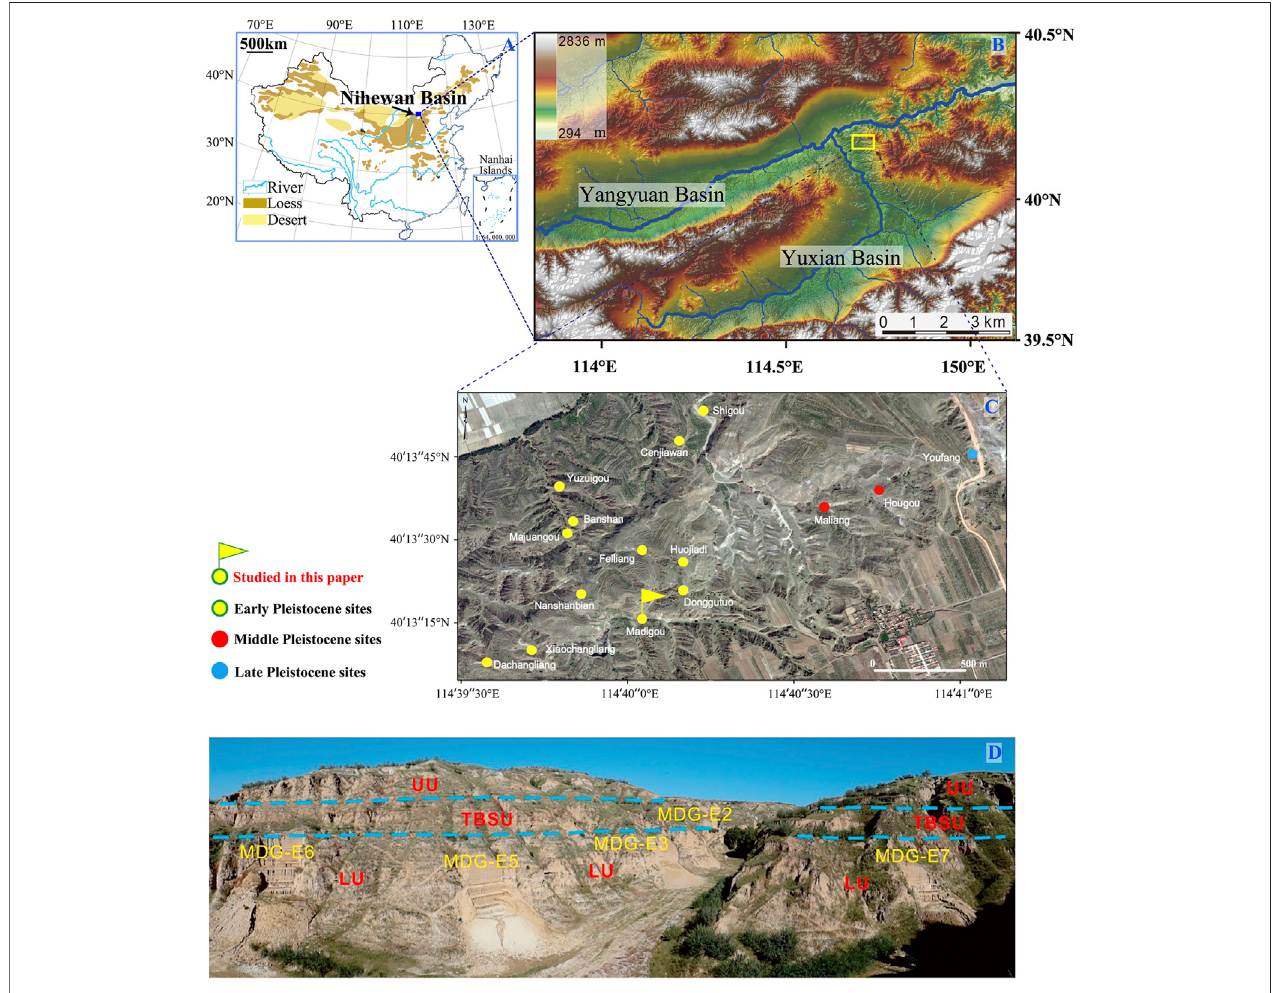
FIGURE 1 | (A – C) Location of the Nihewan Basin in China and the distribution of key Pleistocene sites in the Cenjiawan Platform. (D) Trenches at the MDG site complex, viewed from the southwest. Abbreviations: LU (cid:1) lower unit. TBSU (cid:1) thick brown sand unit. UU (cid:1) upper unit (Pei et al., 2019).